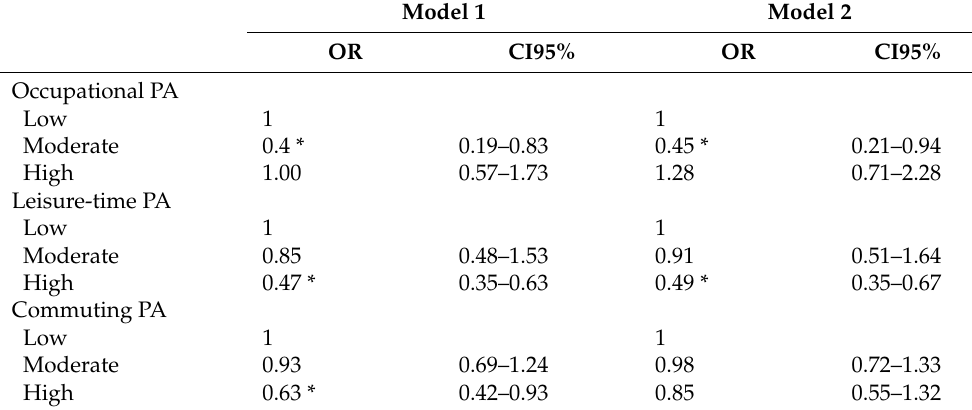
Table 4. Associations between PA and presenting an unhealthy state of mental illness (GHQ12 ≥